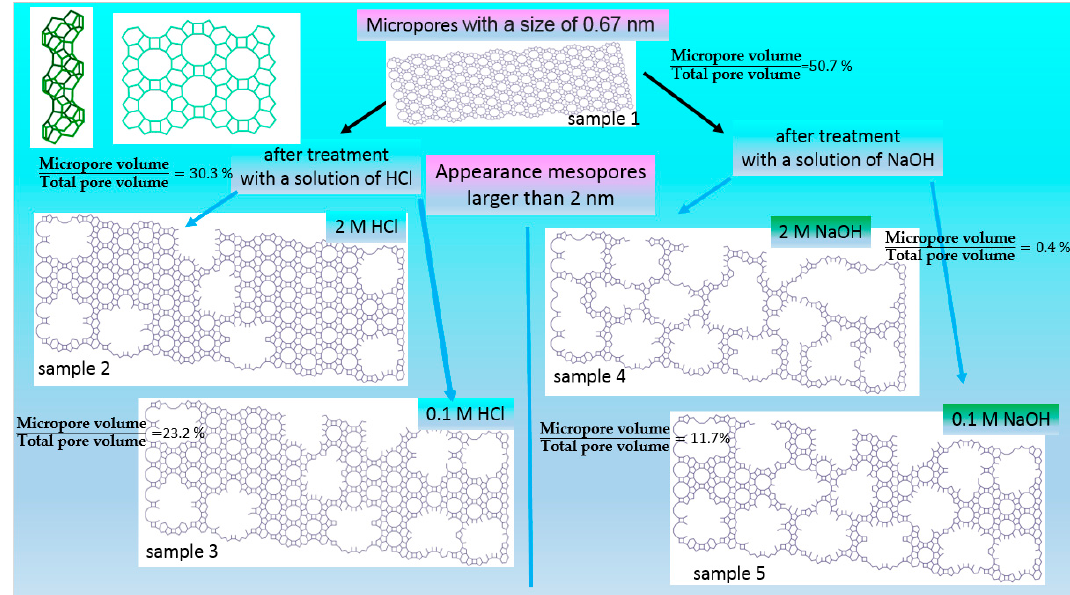
Figure 19. The model structures of samples [compiled by the